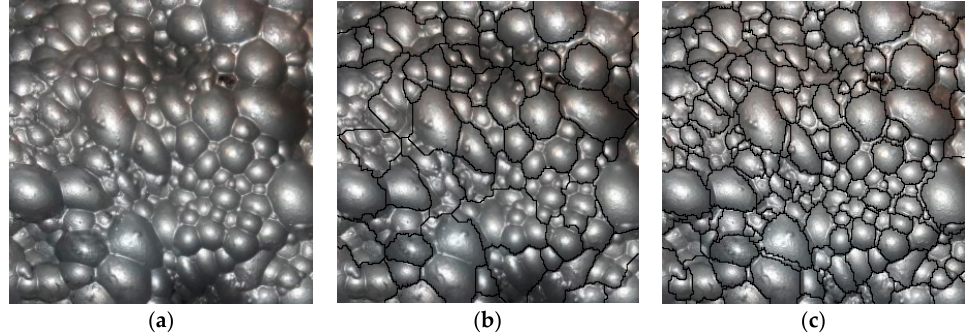
Figure 9. Third type of bubble image segmentation. ( a ) Image with optical correction; ( b ) Segmentation result; ( c ) Adaptive MSR segmentation. Table 2. The number of bubbles in three types of images.